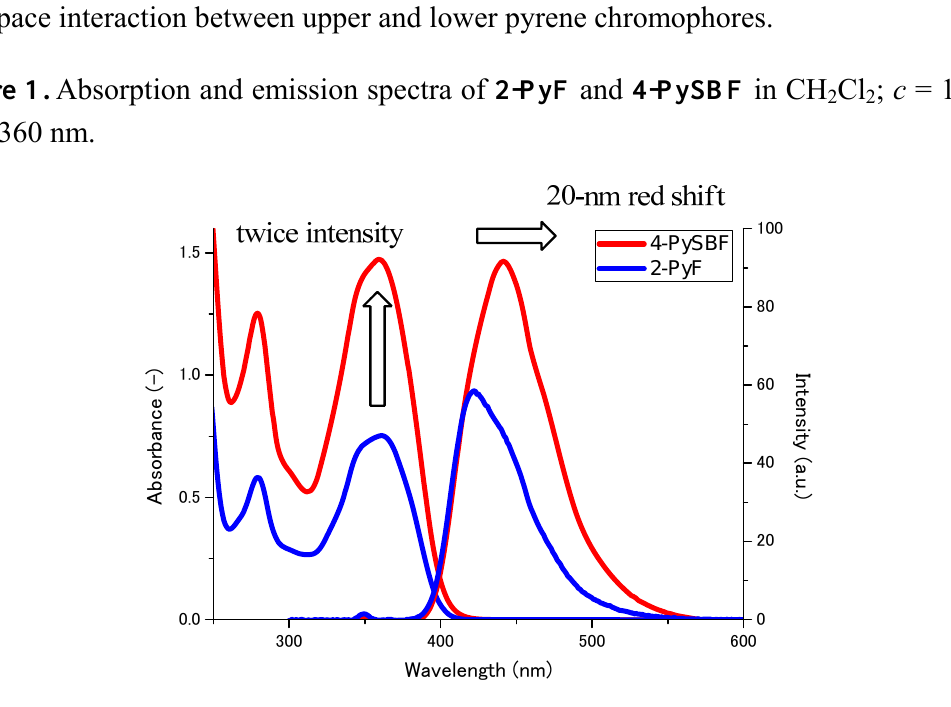
Cl ; c = 10 μ M, 2 2